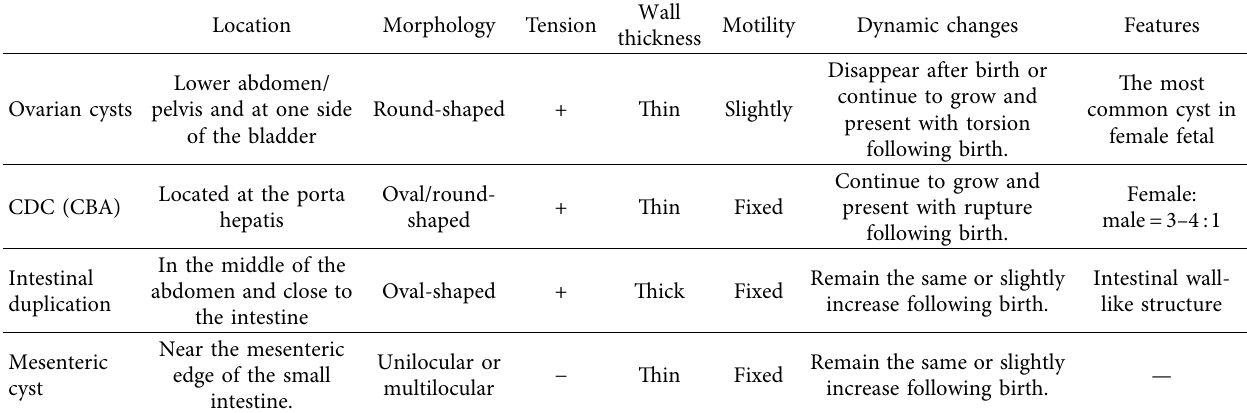
Table 4: Differential of fetal abdominal